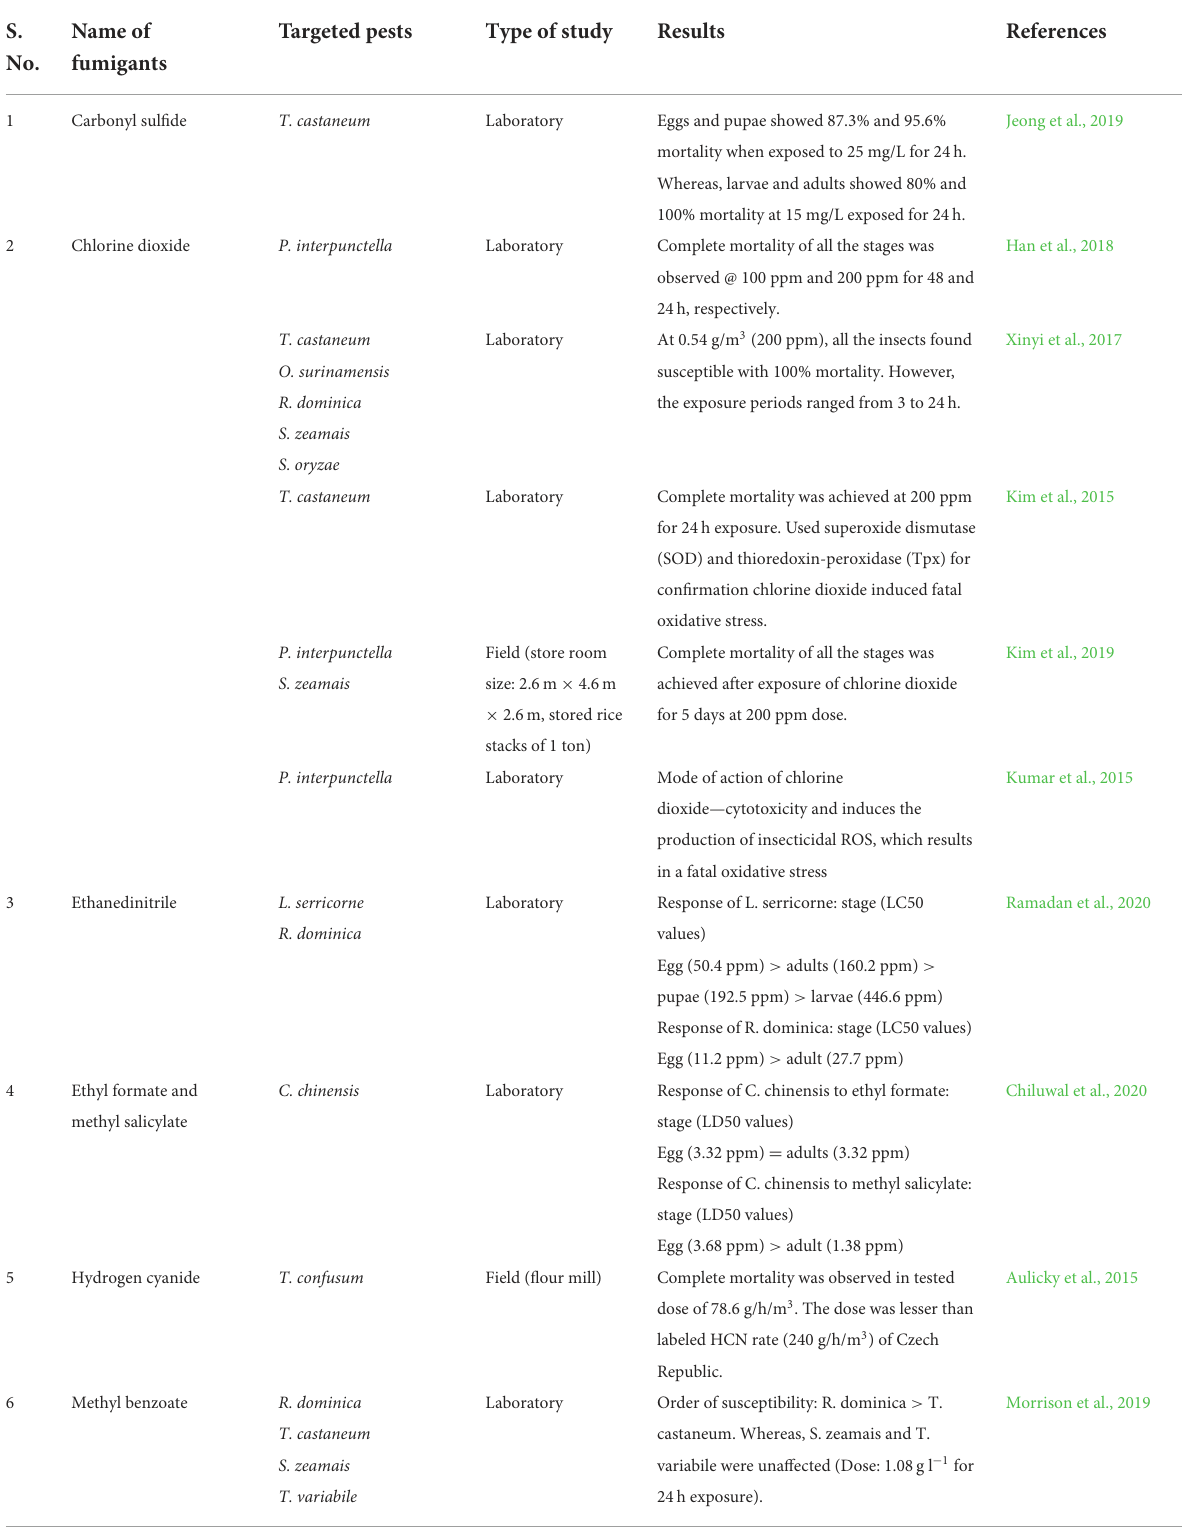
TABLE 2 Recent studies on efficacy of fumigants (excluding phosphine, methyl bromide and essential oils) against stored-product insects (2015 onwards).